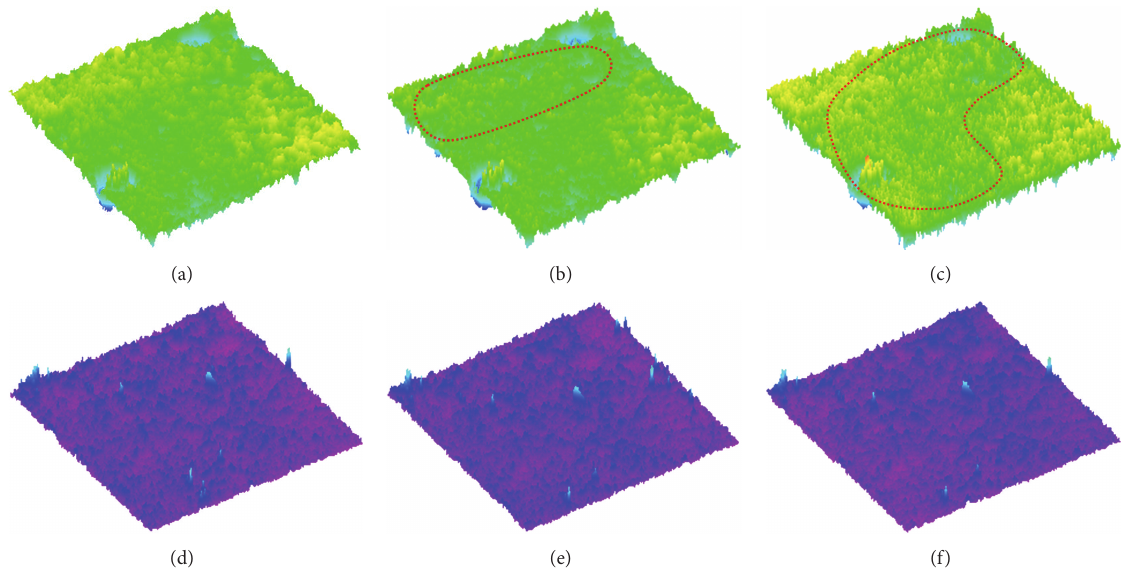
Figure 7: 3D topography of CZTS film (area ∼ 50 𝜇× 50 𝜇 ). (a) Before electrochemical test in europium nitrate aqueous solution, (b) After electrochemical test in europium nitrate solution. (c) After electrochemical test in oxalic acid aqueous solution. (d) Before electrochemical test in formaldehyde aqueous solution. (e) After electrochemical test in formaldehyde aqueous solution. (f) After electrochemical test in sodium sulfite aqueous solution.